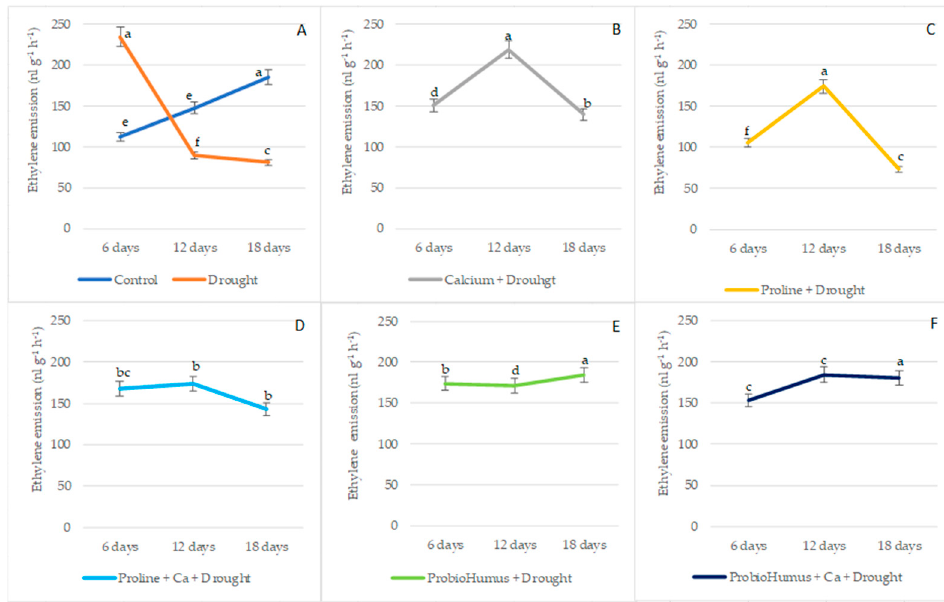
Figure 2. The effect of stress ‐ protecting compounds application and prolonged drought stress (6, 12 and 18 days), on winter wheat ethylene emission level. Used types of application: A – water control and drought control; B – Ca + drought; C – proline + drought, D – proline + Ca + drought; E – Pro ‐ bioHumus + drought; F – ProbioHumus + Ca + drought. Error bars represent the standard deviation of the mean. Different lowercase letters in the same day of drought indicate statistically significant difference ( p < 0.05).